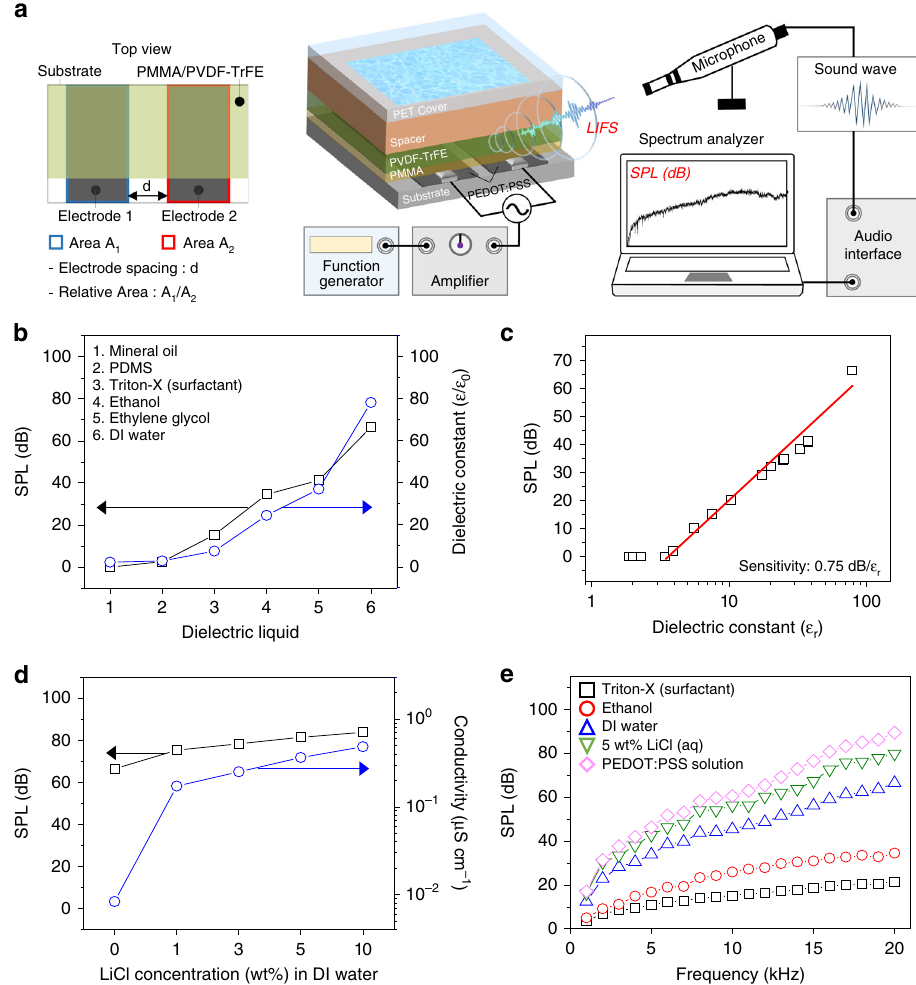
Fig. 2 Sound performance from liquid polarity-interactive ferroelectric actuation. a Schematics of architecture and sound pressure level (SPL) detection system of the planar-type liquid-interactive ferroelectric sound (LIFS) alternating current (AC) device. SPL values arising from LIFS of a liquid were obtained as a function of applied AC input signal. b SPL values of six liquids examined with different dielectric constants on an LIFS AC device. The SPL values are proportional to the dielectric constants of the liquids. The device was operated at an AC frequency and voltage of 20 kHz and 100 V, respectively. c SPL values of 18 liquids examined with different dielectric constants, and the sensitivity of an LIFS AC device obtained from a linear slope of the curve. The device was operated at an AC frequency and voltage of 20 kHz and 100 V, respectively. d SPL values of fi ve liquids examined with different ionic conductivities controlled by the amount of LiCl in water on an LIFS AC device. SPL values increased with the ionic conductivities of the liquids. The device was operated at an AC frequency and voltage of 20 kHz and 100 V, respectively. e SPL values of fi ve liquids with different polarities on an LIFS AC device as a function of AC frequency at the AC voltage of 100